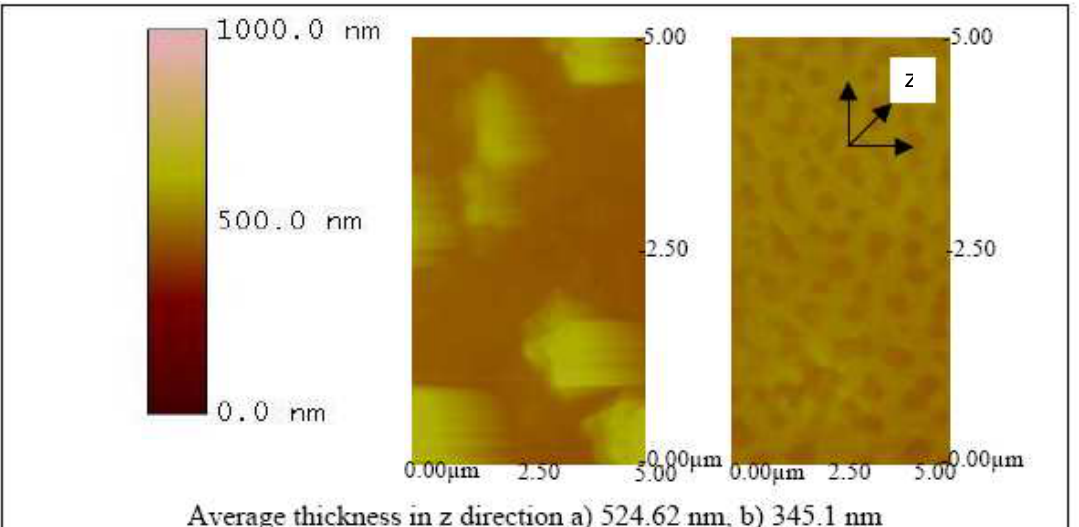
Figure 12. Atomic force microscopy images of a) ITO-Pani biosensor (65KDa) tested with a)10 6 CCID/ml and b) 10 4 CCID/ml of bovine viral diarrhea virus